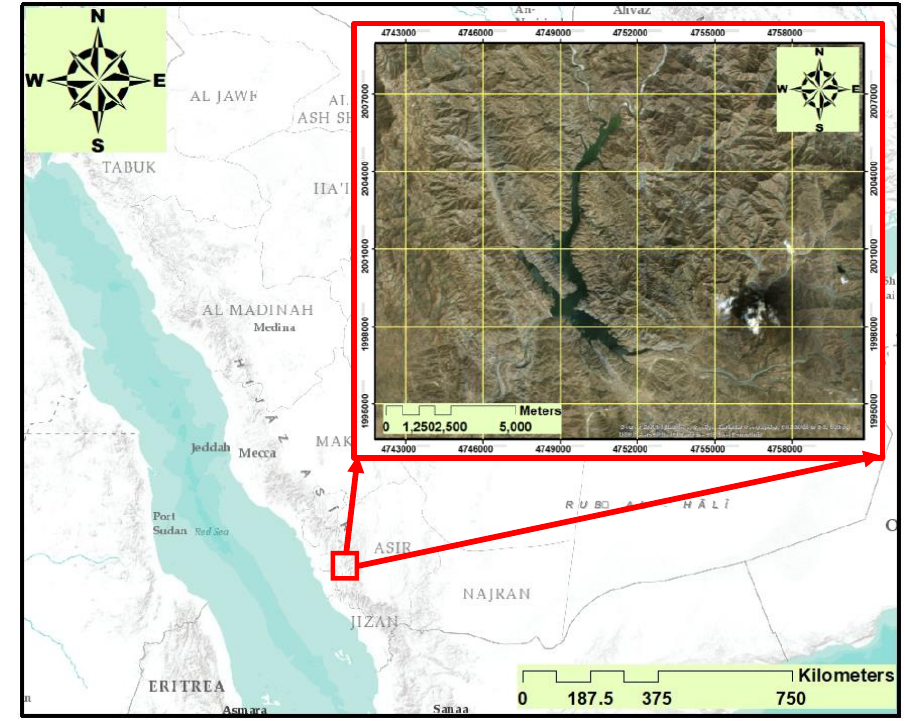
Figure 1. Location of the study area.